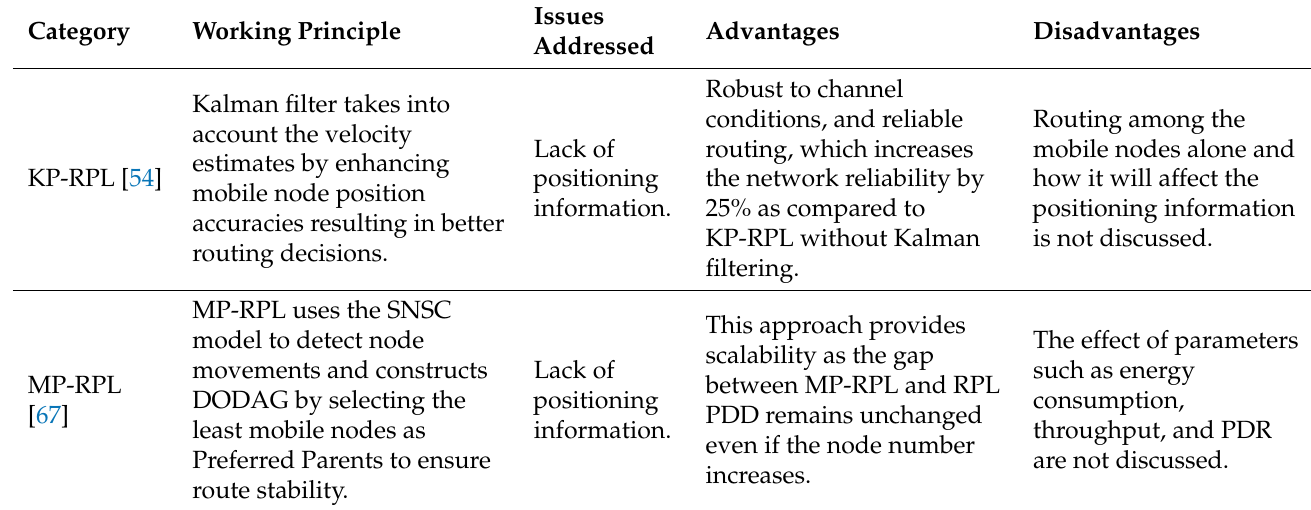
Table 4. Summary of Position-based